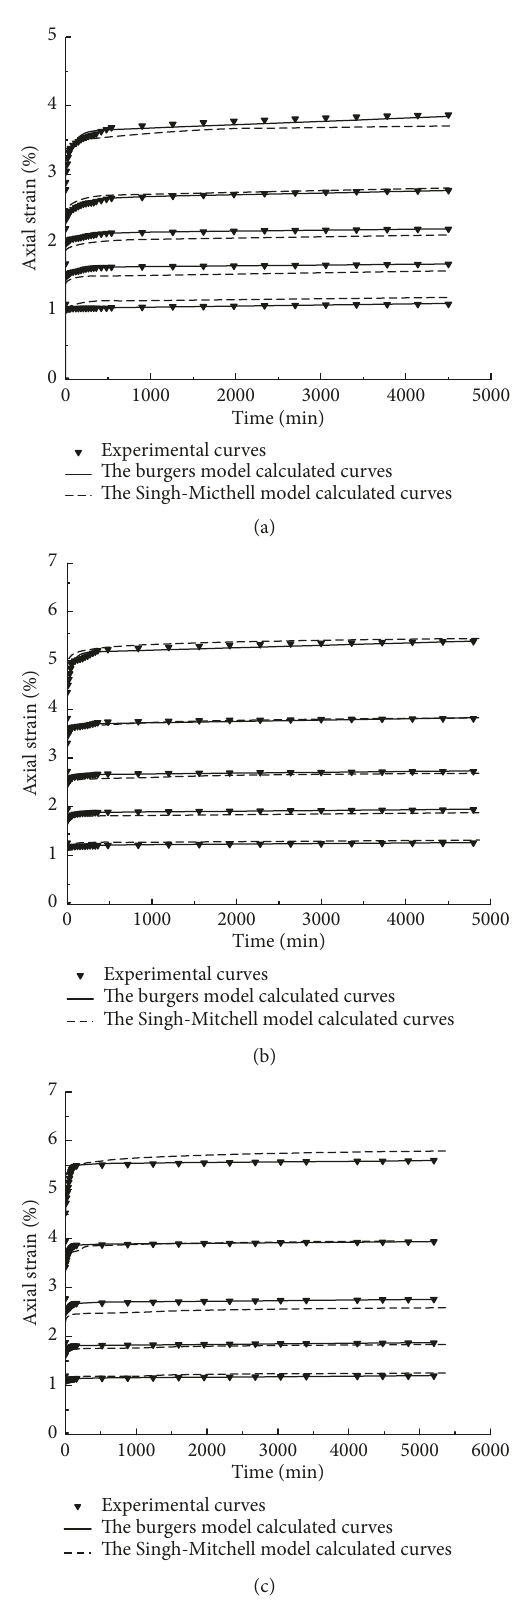
Figure 7: Comparison between the Burgers mode predicted creep curves and the experimental curves. Confining pressure: (a) 100kPa, (b) 150kPa, and (c)